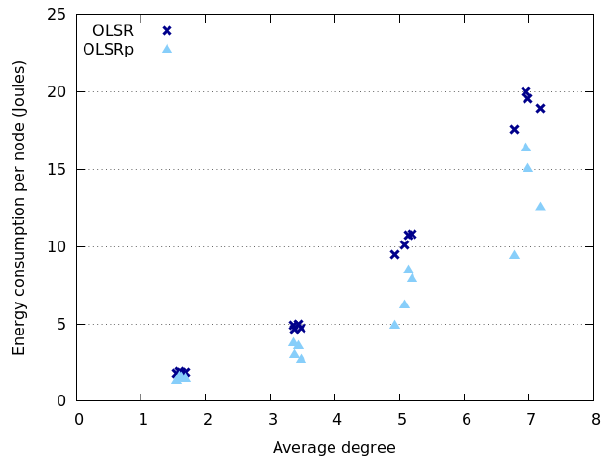
Figure 6. Energy consumption versus network degree when nodes follow a Random Walk model.